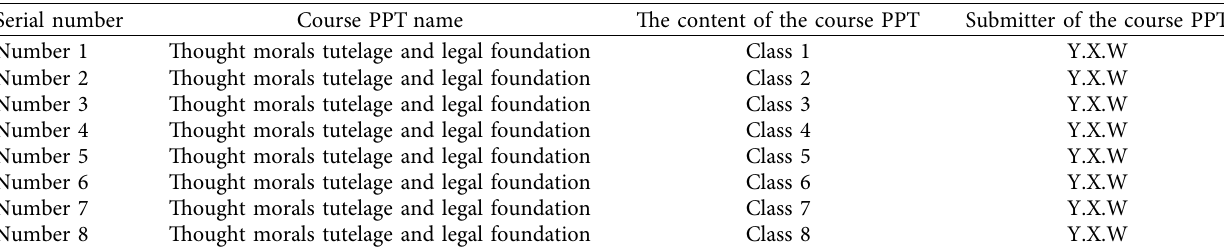
Table 3: Test on courseware management of the